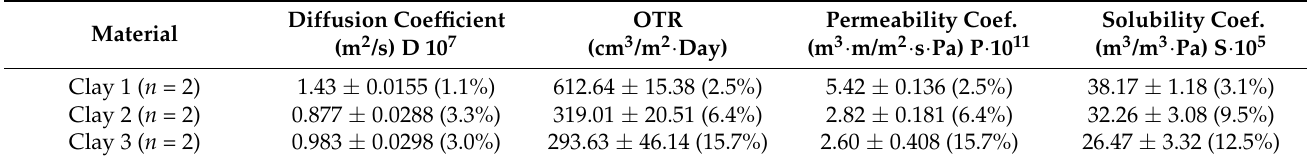
Table 5. Main permeation results of tested claystone samples.